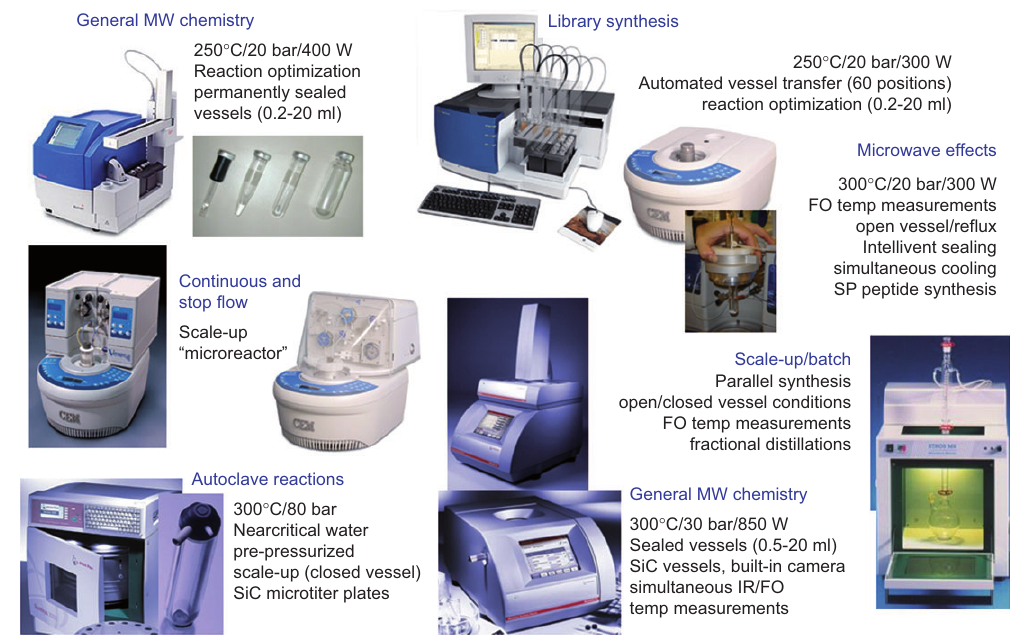
Figure 1 Dedicated single and multimode microwave reactors available at the